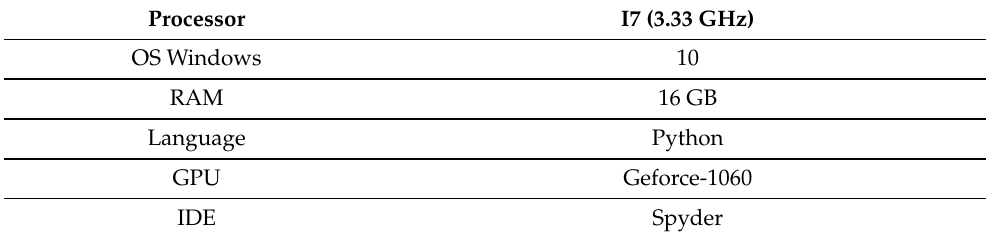
Table 4. Experimental